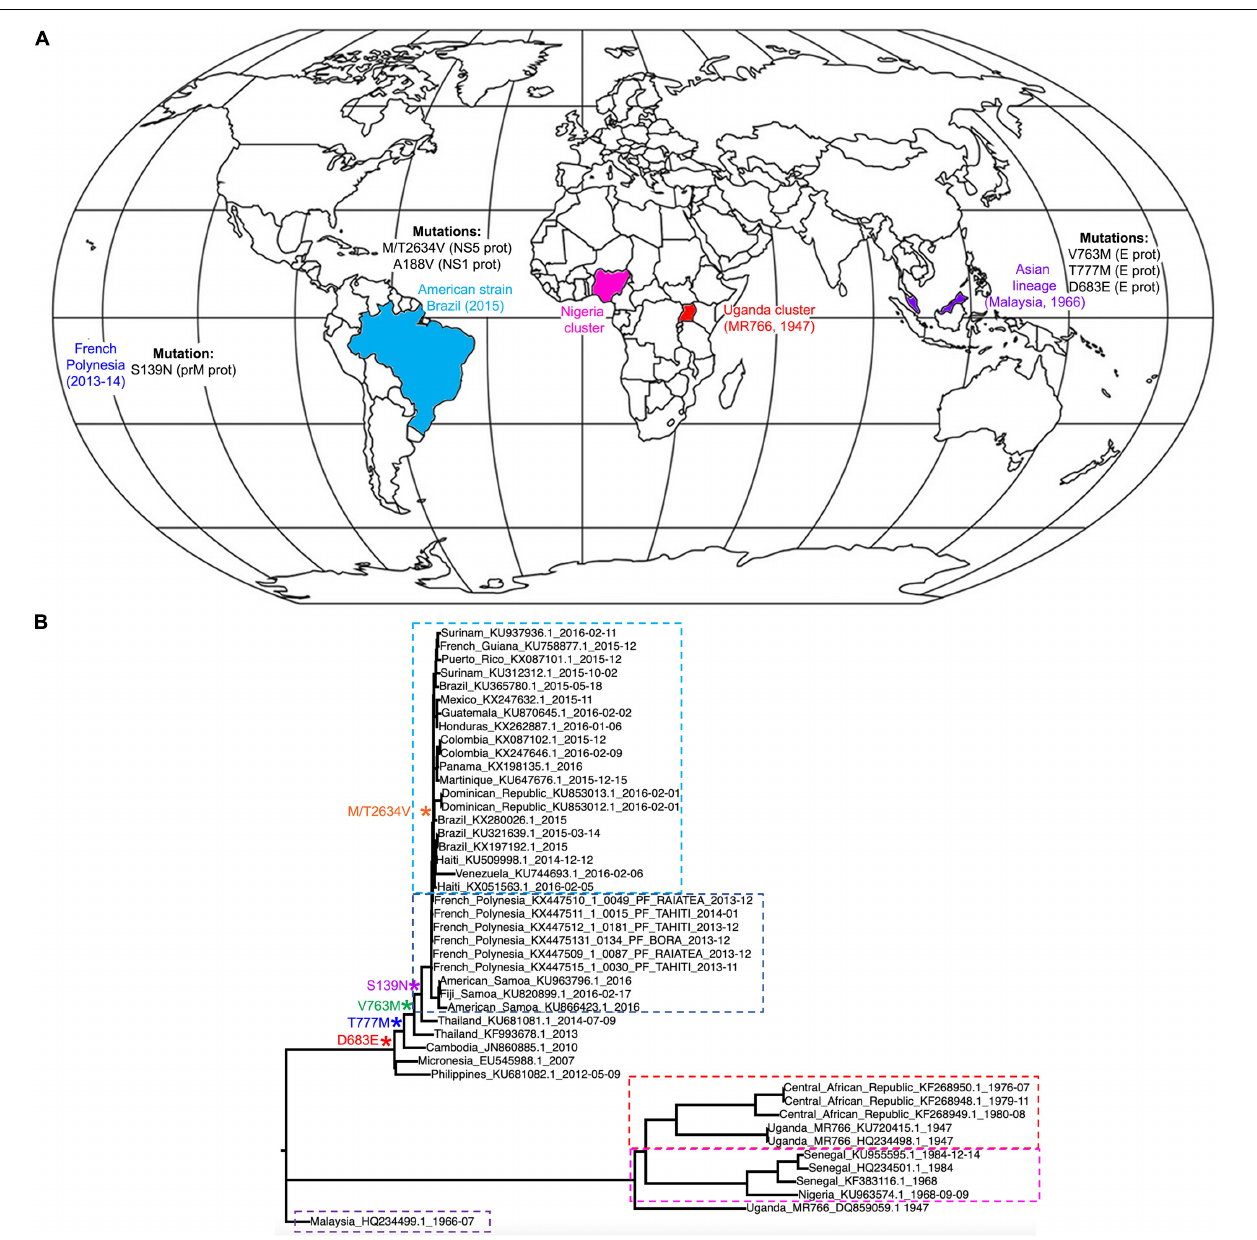
FIGURE 2 | Lineage and global spread. (A) World distribution of ZIKV following its emergence in Uganda in 1947 and its diversion into African, Asian and American lineages. The map also indicates the main mutations that the different lineages have acquired in order to increase transmission and pathogenicity. (B) ZIKV phylogeny of African, Asian/Pacific and Latin American virus isolates, including mapping of amino acid substitutions cited in section “Mutations Affecting Viral Properties.” Selected sequences from Pettersson et al., 2016 were used to create a nucleotide phylogenetic tree under maximum likelihood using the IQTREE web server (Trifinopoulos et al., 2016). For clarity, Ugandan cluster isolates are boxed in red, Nigerian in pink, Malaysian in purple, French Polynesian in dark blue and American in light